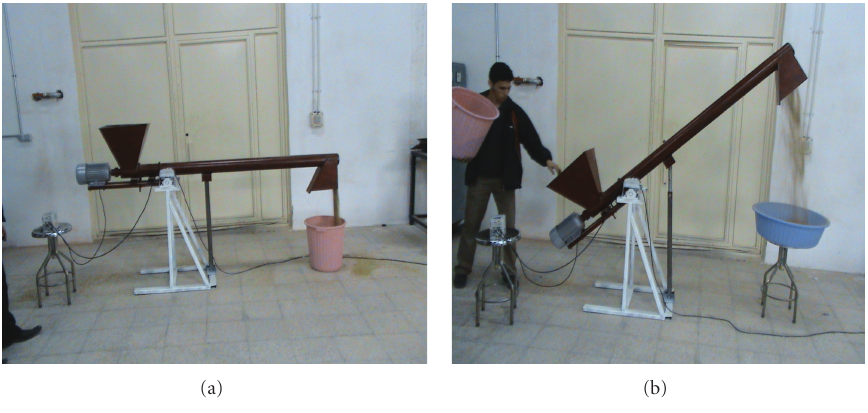
Figure 1: Tested screw conveyor at two conditions of (a) horizontal and (b) inclination angle of 40 ◦